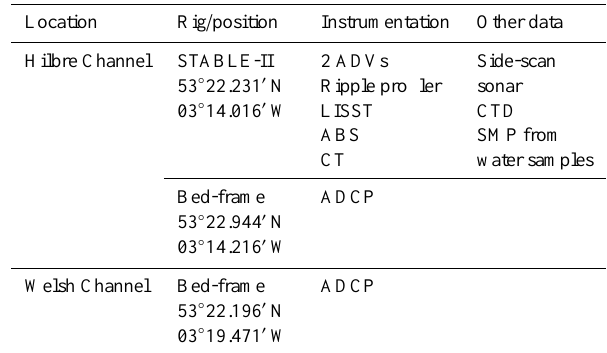
Table 4. Summary of the February 2005 data.